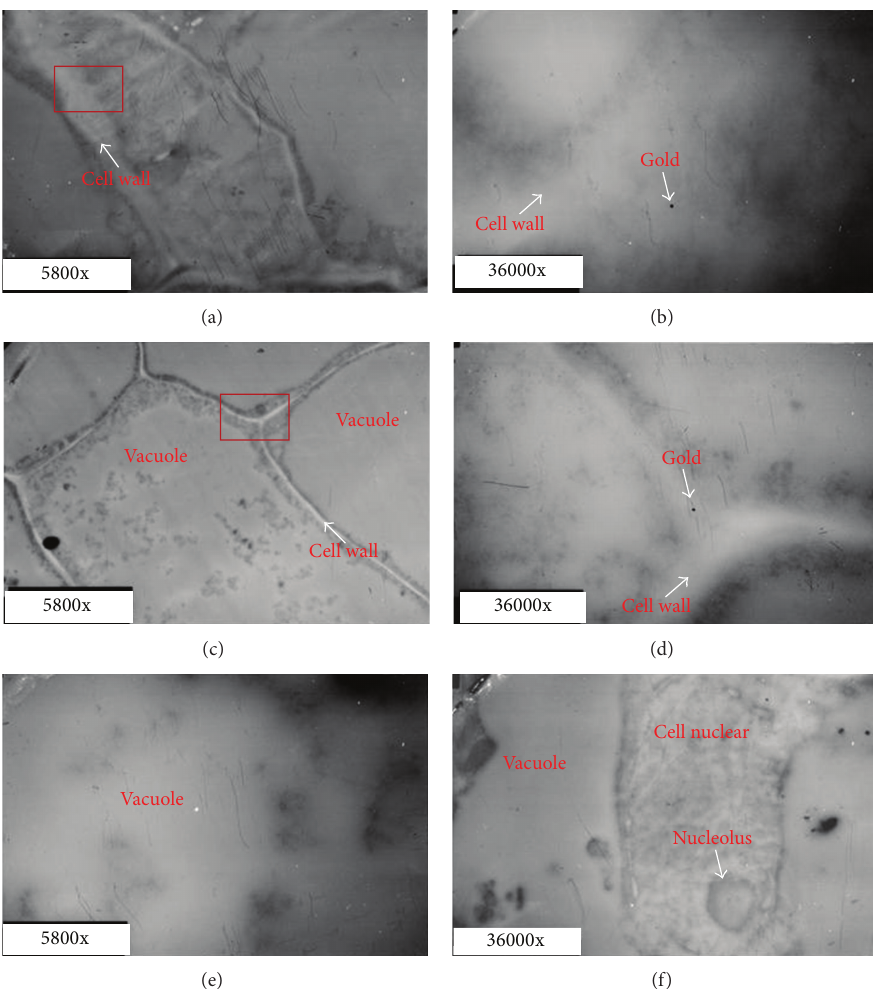
Figure 4: Transmission electron micrographs of tomato pedicel and localization of polygalacturonase (PG) in abscission zone cells with immunogold labeling (0h). (a) and (b): cortex; (c) and (d): central parenchymatous region; (e): vacuole; (f): cell nucleus; (b) and (d) are enlarged photos for the rectangles region in (a) and (c),